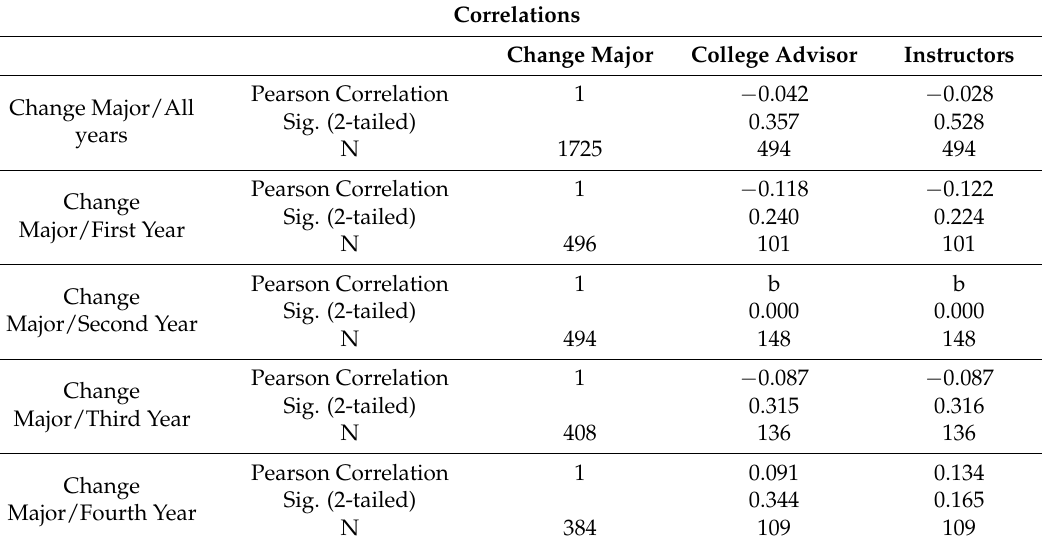
Table 7. Correlations of college advisor positive factor, instructors’ positive factor and major